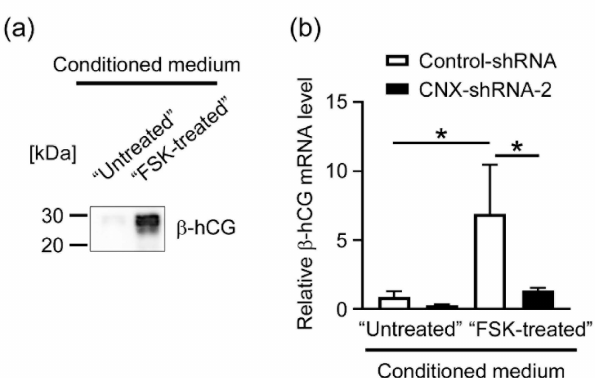
Figure 5. CNX knockdown attenuated autocrine-dependent induction of β -hCG in BeWo cells. BeWo cells-derived conditioned medium samples were obtained as FSK-treated CM ( β -hCG-containing medium) and Untreated CM (control medium) as described in Materials and Methods. ( a ) FSK- induced production of β -hCG was examined in the conditioned medium samples by immunoblot analysis using the specific antibody. ( b ) CNX-knockdown cells (CNX-shRNA-2) and control cells (Control-shRNA) were treated for 48 h with FSK-treated CM or Untreated CM as described in Materials and Methods. Then the expression of β -hCG mRNA was examined by RT-qPCR. * p < 0.05 vs. FSK-treated